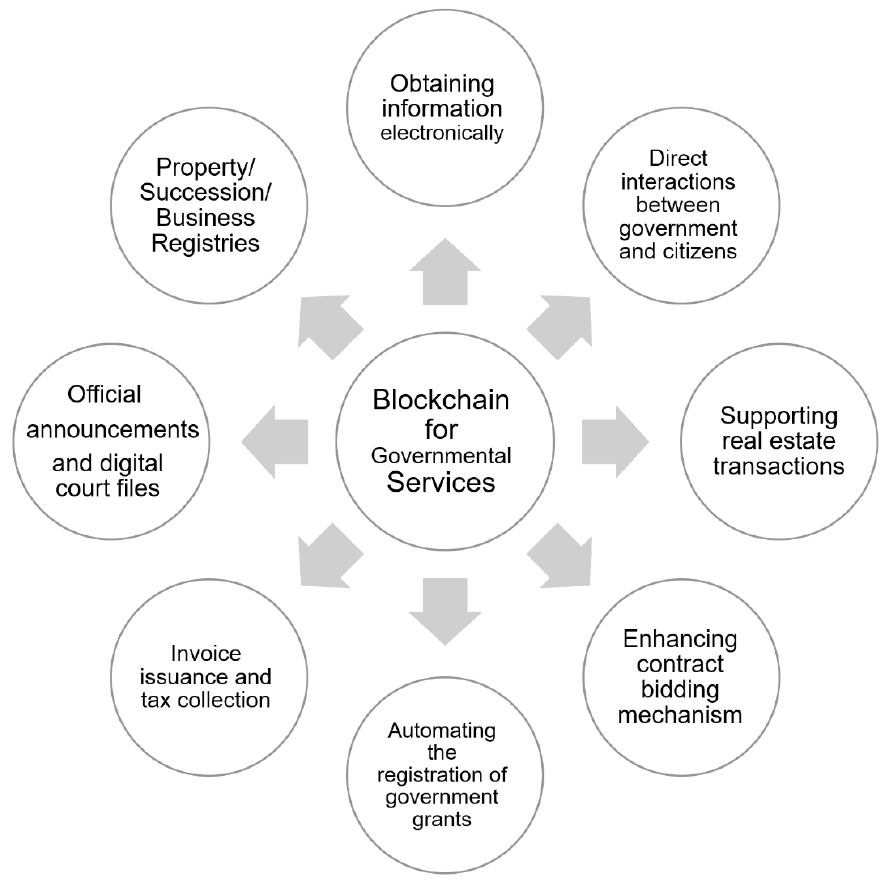
Figure 9. Blockchain for governmental